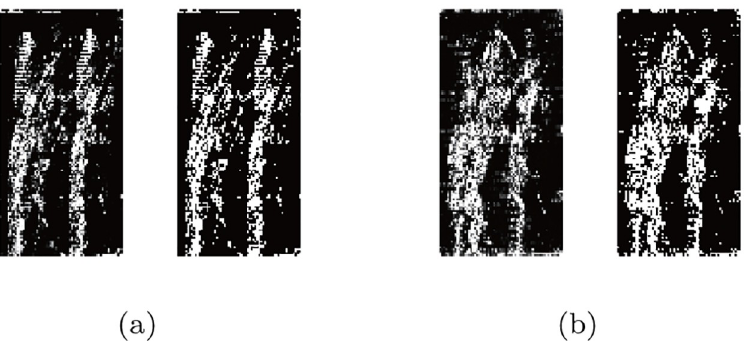
Fig 6. Two subbands of the state probability of “Zelda”, the leftside of each shows unprocessed subband and the rightside shows processed subband. It can be observed that the state probability processed by PCNN is clearer than the unprocessed probability and easier to classify.